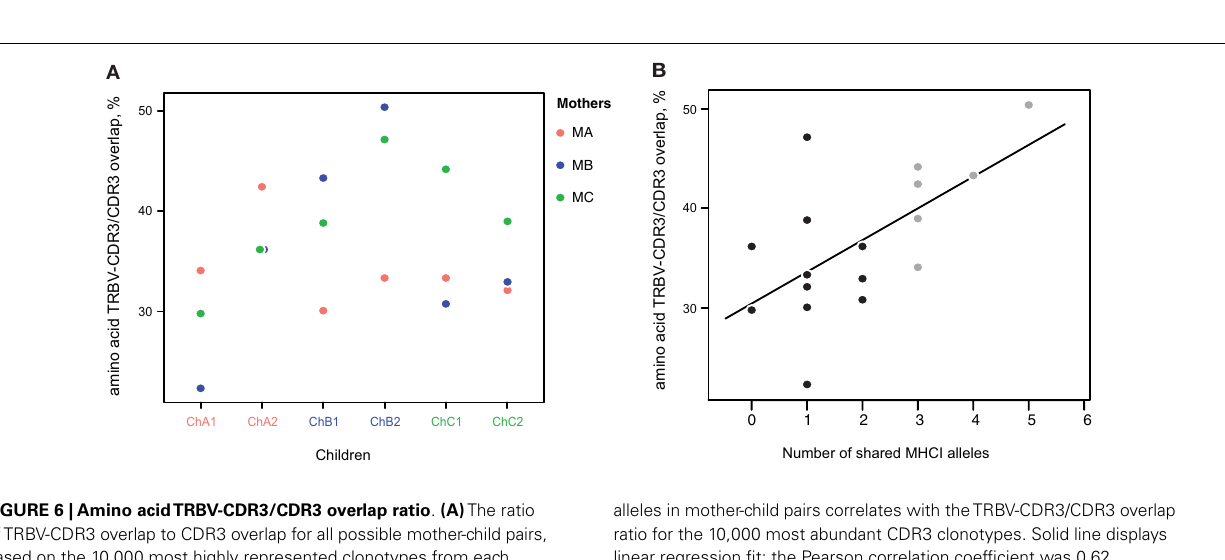
FIGURE 6 |Amino acidTRBV-CDR3/CDR3 overlap ratio . (A) The ratio ofTRBV-CDR3 overlap to CDR3 overlap for all possible mother-child pairs, based on the 10,000 most highly represented clonotypes from each donor. Related mother-child pairs had a higher ratio relative to children with either of the unrelated mothers. (B) The number of shared MHC-I